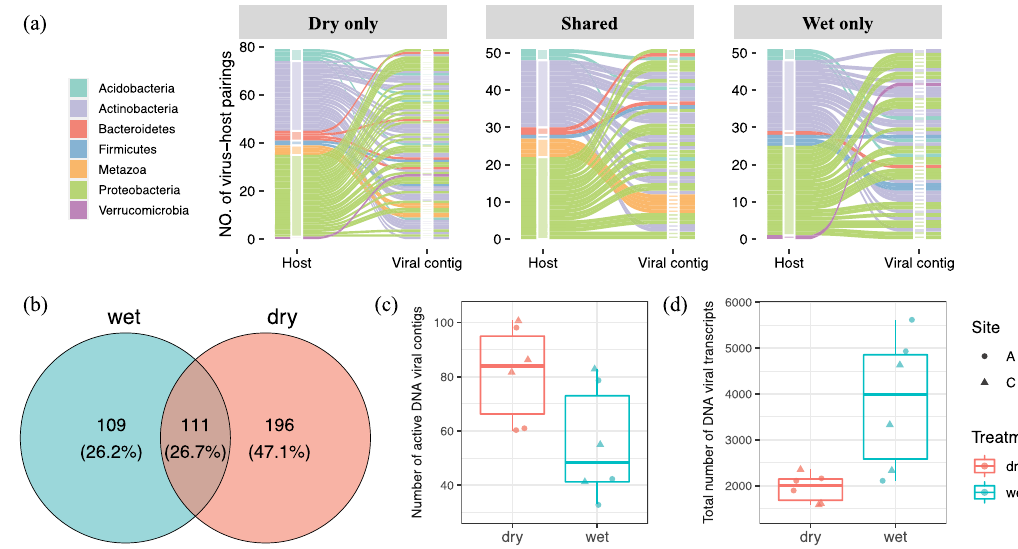
Fig. 1 Transcribed DNA viral communities and their responses to wet and dry soil conditions. a An alluvium plot that illustrates pairings of the transcribed DNA viral contigs to putative host phyla. The transcribed DNA viral community was comprised of viral contigs from the curated DNA viral databases that were mapped by quality- fi ltered metatranscriptomic reads. The alluvia are colored by host taxa ( fi rst x axis of each sub-panel) assigned to respective transcribed DNA viral contigs (second x axis of each sub-panel). b A Venn diagram showing the number of unique transcribed DNA viral contigs detected in both wet and dry soils and ones exclusively detected in one of the soils. c Number of unique DNA viral contigs detected. A t -Test shows signi fi cantly more DNA contigs were transcribed in dry soil ( p = 0.044). d Number of transcripts that mapped to the DNA viral contigs. For panels ( c ) and ( d ), the two independent fi eld sites of Konza Experimental Field Station are indicated as site A (circles) and site C (triangles), with the wet soil in blue and dry soil in